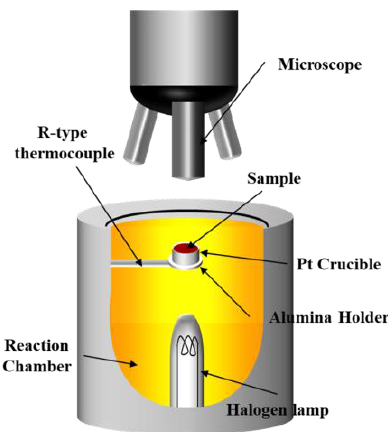
Figure 2. Schematic diagram of the confocal laser microscopy (CLM) setup.